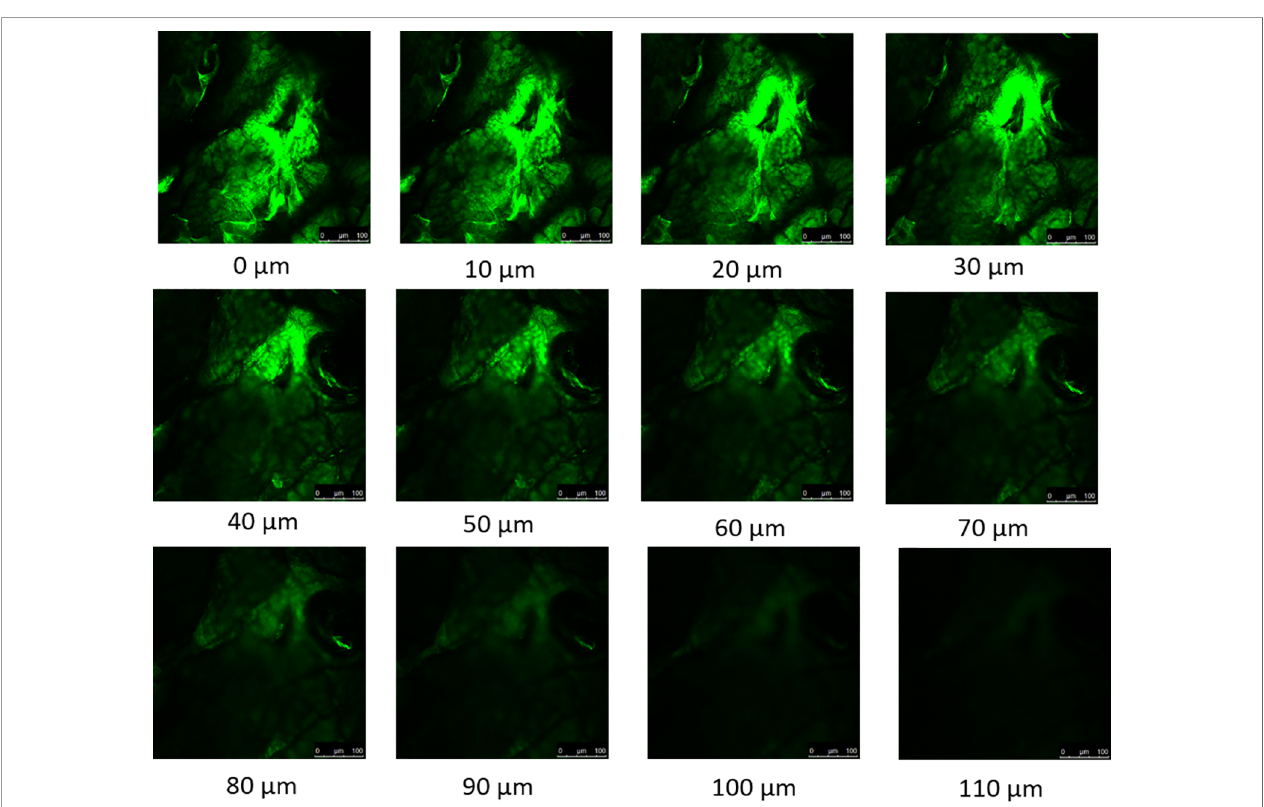
FIGURE 1 | Confocal microscopy z-stack of micropores created by maltose microneedle reveals the depth of penetration to be approximately 110 µm.